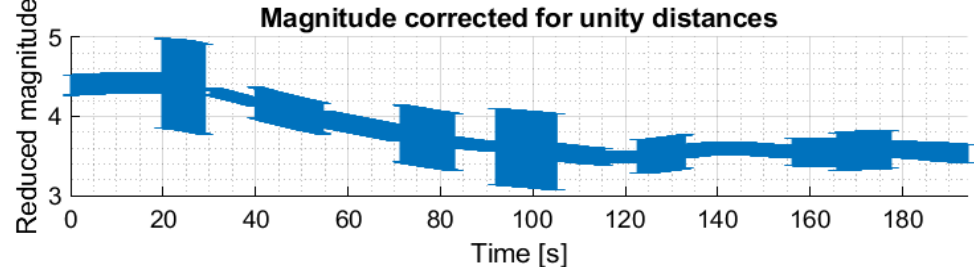
Figure 11. Observed light-curve of Cosmos 2297 Rocket (SSN 23405) taken the 28th of August 2020 from SCUDO observatory.